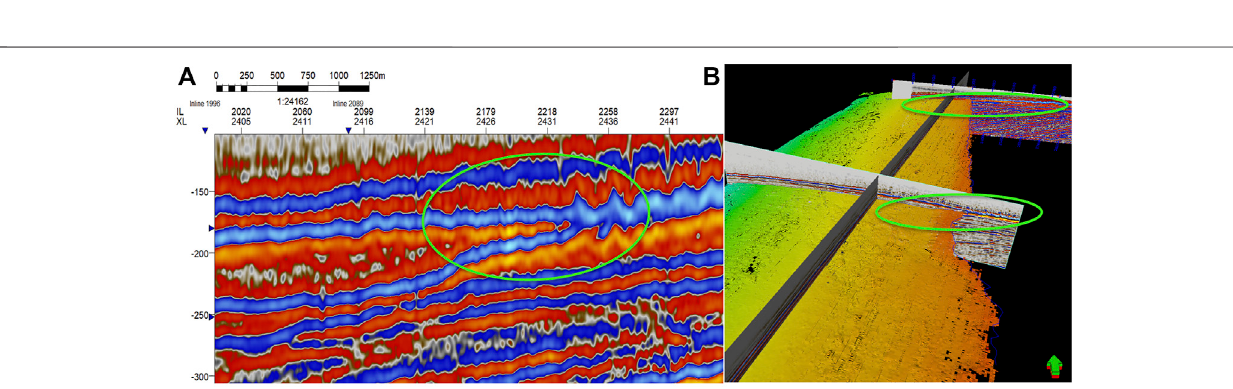
Frontiers in Earth Science |